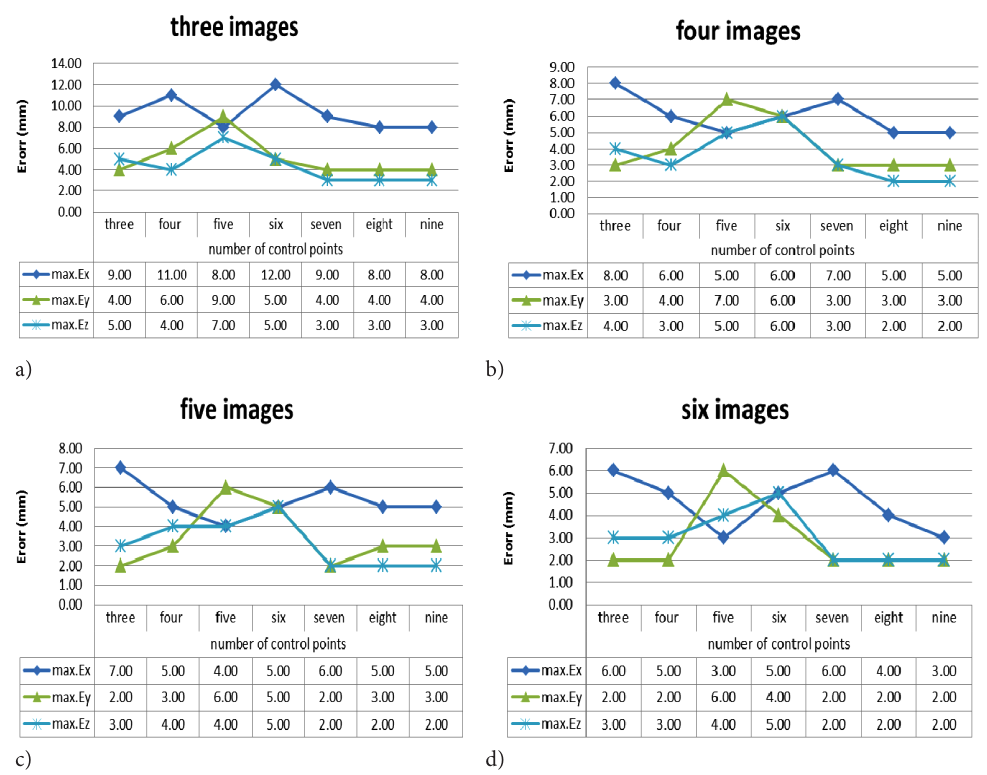
Figure 9. Effect of ground control point’s numbers on maximum point coordinates differences between total station observations and metric camera with